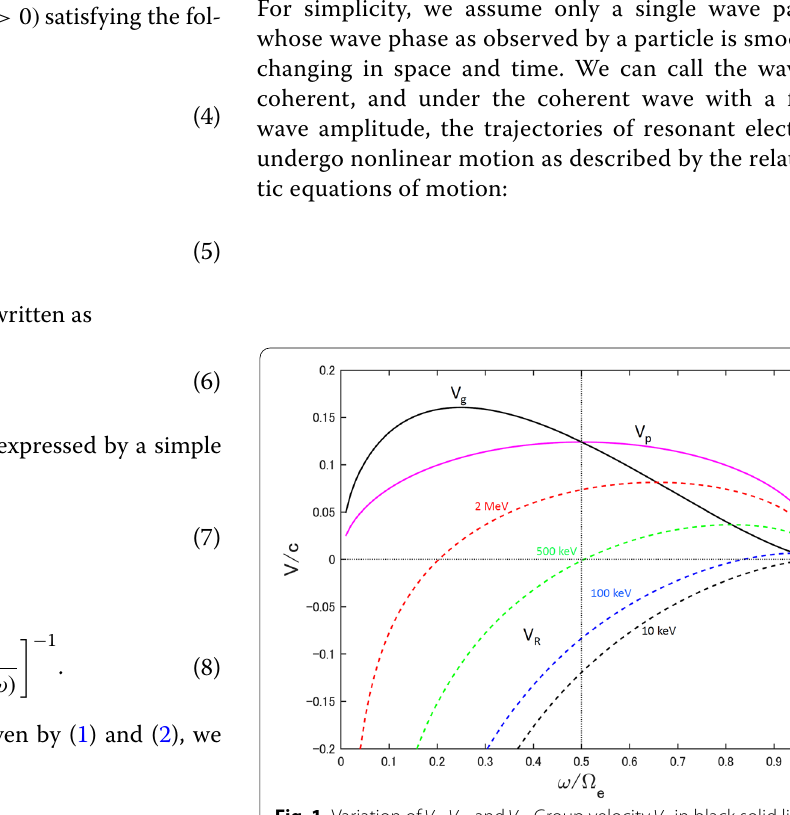
Fig. 1 Variation of V g , V p , and V R . Group velocity V g in black solid line, phase velocity V p in magenta, and resonance velocities V R in dashed line for different energies K 10 keV (black), 100 keV (blue), 500 keV = (green), and 2 MeV (red) as functions of frequency ω with the plasma 4 � frequency ω pe =